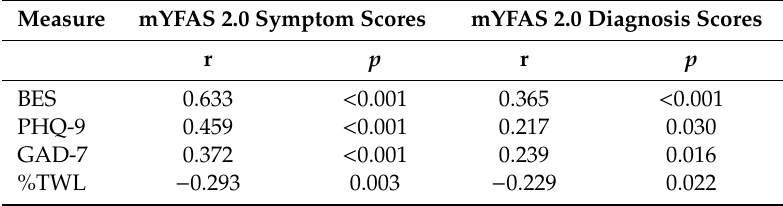
Table 2. Correlates of Modified Yale Food Addiction Scale Version 2.0 (mYFAS 2.0) symptom and diagnosis scores at 1 year post-surgery.